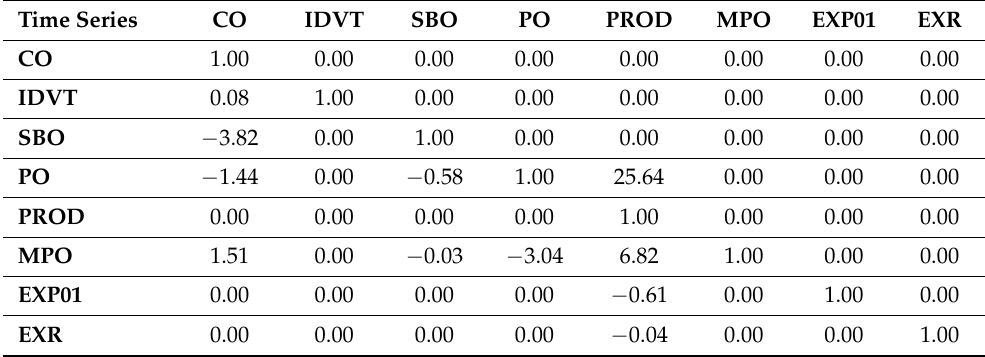
Table 7. Recovered structural matrix A under the second set of restrictions following Zaidi et al. (2021) [4] except for IDVT, as in Table 5.